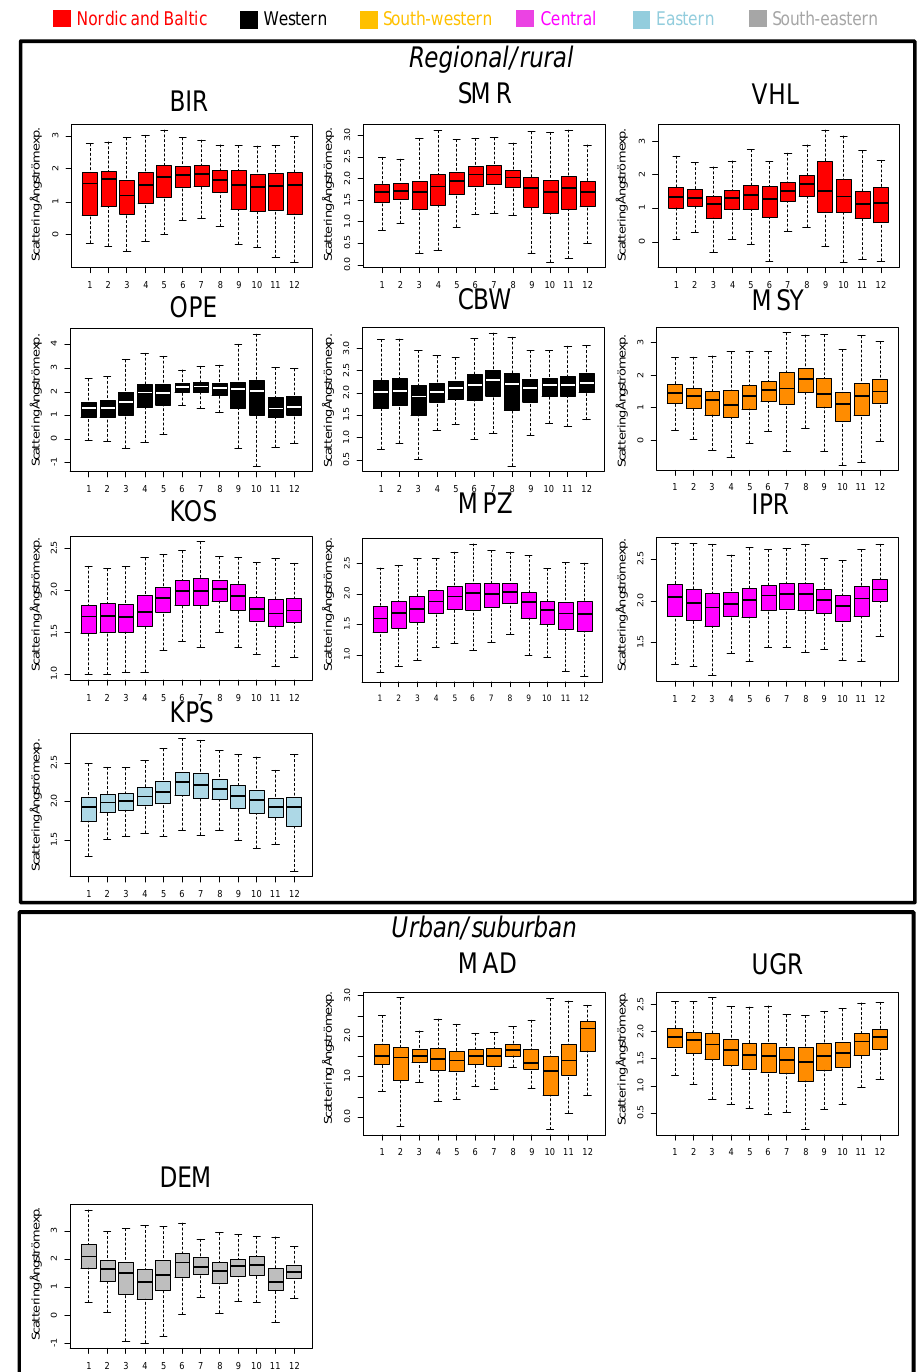
Figure 7. Seasonal cycles of SAE (calculated using the three nephelometer wavelengths).